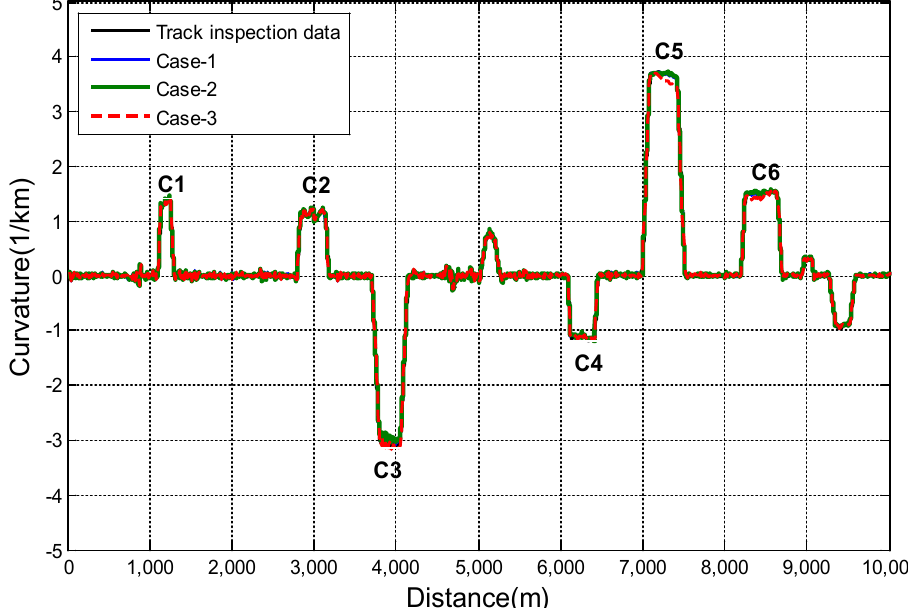
Figure 8. Curvature simulation result. Table 1. Curvature analysis results.